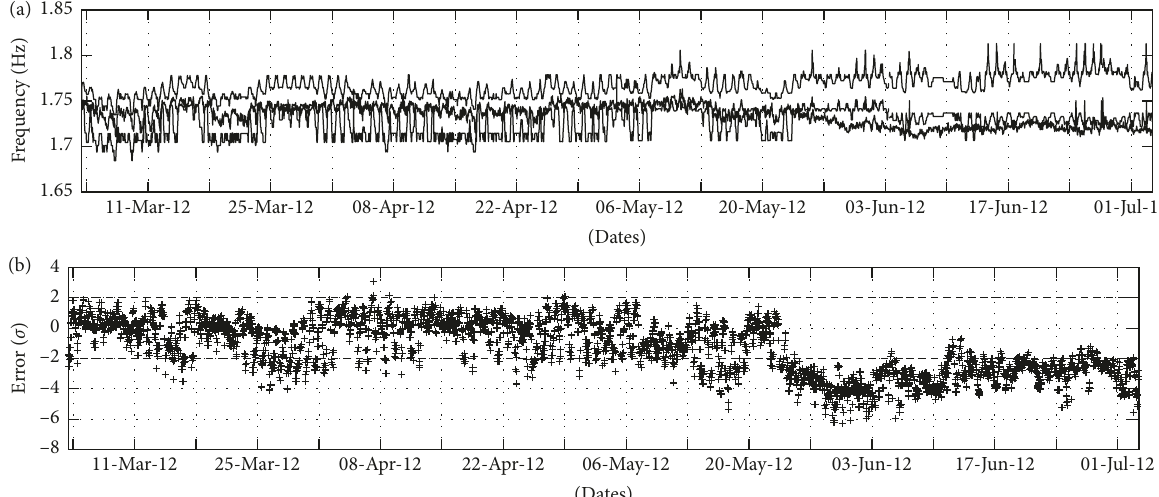
Figure 5: (a) Frequencies observed at OT (thick black line) and expected range of variation (thin black lines) computed as the mean value 2 σ , between 1 March and 3 July 2012. (b) Prediction errors computed with (1) (scatter) and compared with the upper and lower thresholds ( ε 2 σ ) (dashed (cid:31) ±